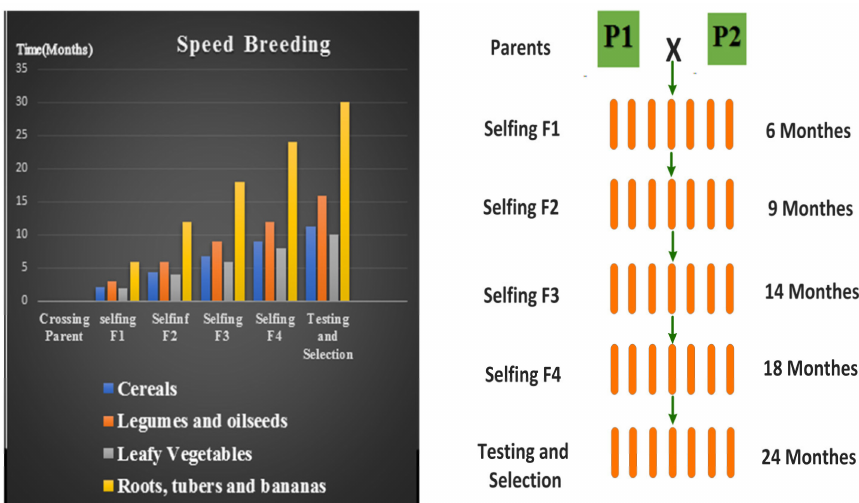
Figure 5. Graphical presentation of the elite line development procedure. Comparison of time (in months) required to develop elite lines from selected parents of some crops. Extended photoperiods induced earlier flowering and created 4 generations annually. The optimal temperature regime (maximum and minimum temperatures) should be applied for each crop. A higher temperature should be maintained during the photoperiod, whereas a fall in temperature during the dark period can aid in stress recovery. At the University of Queensland; (UQ), a 12-h 22 ◦ C / 17 ◦ C temperature cycling regime with 2 h of darkness occurring within 12 h of 17 ◦ C has proven successful. The figure is briefly modified from Watson et al.